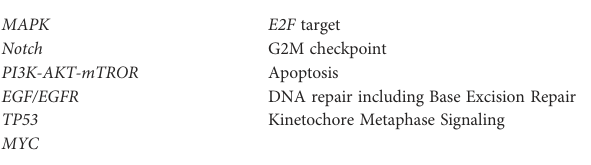
TABLE 3 Examples of pathways shared between canine bladder cancer detected through screening and human invasive bladder cancer (30, 39, 44, 45, 68 – 74).